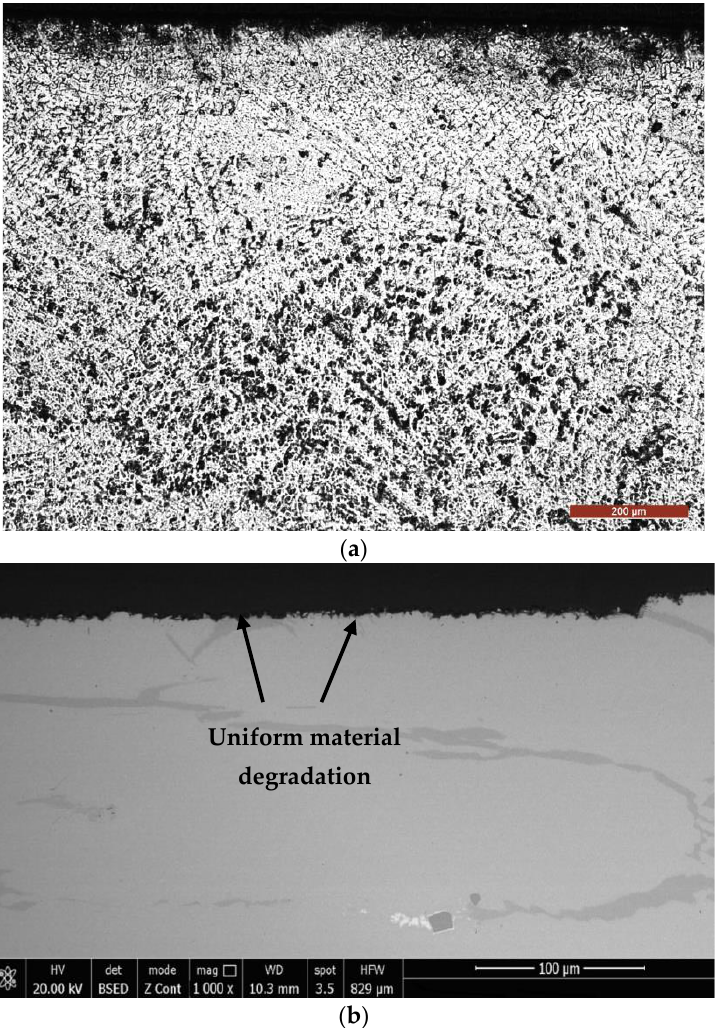
Figure 14. SEM microscopy through the remelted layer with Is = 150 A and after 165 min cavitation time: ( a ) — Villela etched; ( b ) — unetched.